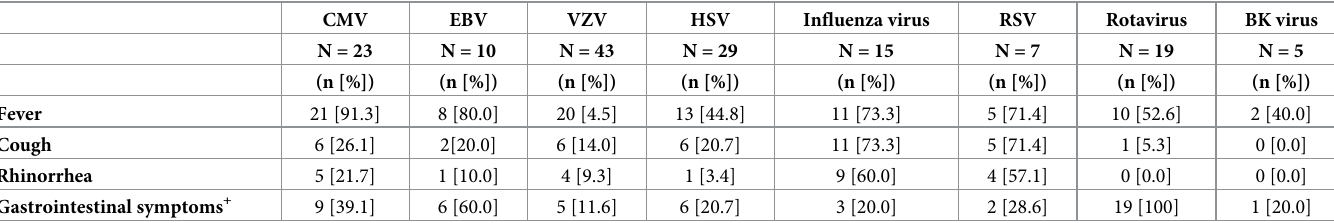
Table 4. Presenting Symptoms associated with different types of viral infections in children and adolescents with cancer.